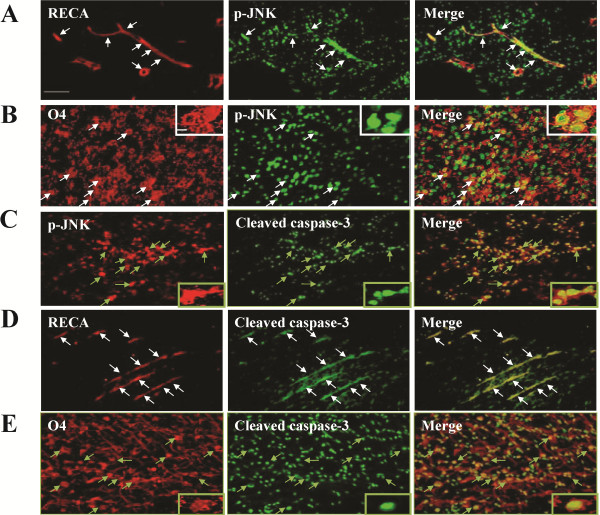
JNK activation-mediated apoptosis in cerebral vascular endothelial cells and oligodendrocyte progenitors in the white matter after lipopolysaccharide-sensitized hypoxic-ischemia. Immunofluorescence of the lipopolysaccharide (LPS) + hypoxic-ischemic (HI) group 24 h post-insult showed numerous phospho-c-Jun N-terminal kinase (p-JNK)-positive cells attached to or located around the microvessels in the white matter (A). RECA-positive endothelial cells (A) and O4-positive oligodendrocyte progenitors (B) co-expressed p-JNK. Many p-JNK-positive cells (C), RECA-positive endothelial cells (D) and O4-positive oligodendrocyte progenitors (E) expressed cleaved caspase 3. Scale bar = 25 μm. Inset scale bar = 2.5 μm.